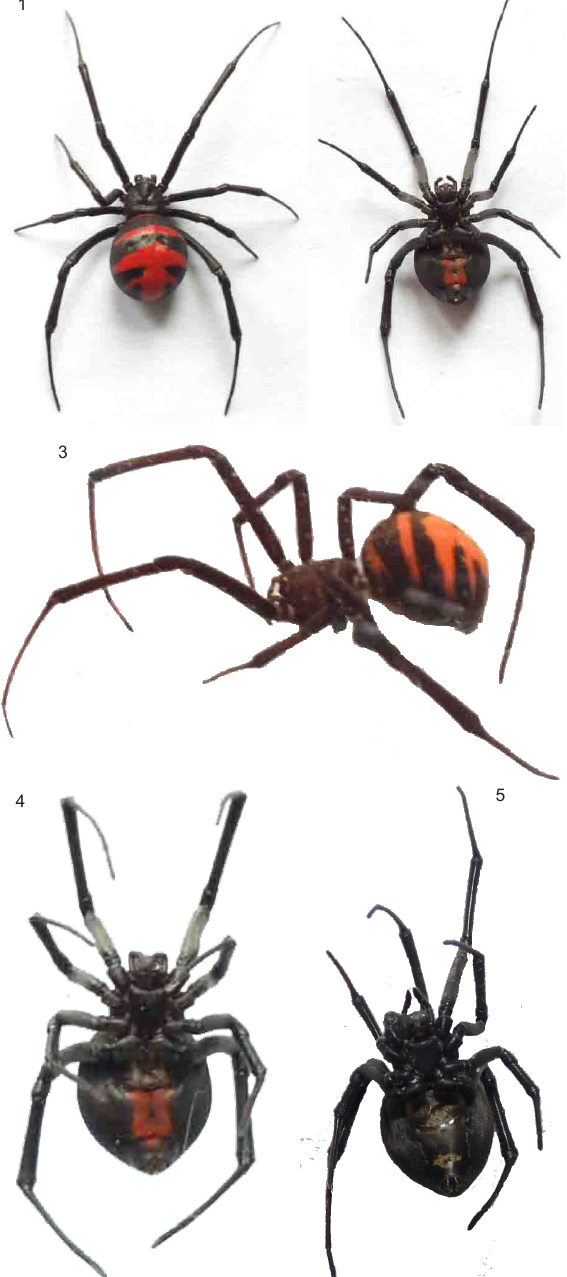
Images 1–5. Latrodectus elegans , female. 1 - Dorsal view; 2 - Ventral view; 3 - Lateral view; 4 - Ventral view; 5 - Epigynum, dorsal view. Images 1–3 of specimen WILD-11-ARA-1113, 4–5 of specimen